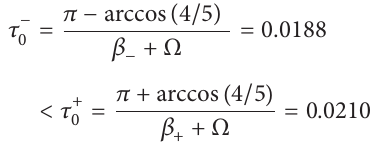
and V 2 (𝜃) satisfies [( 𝑖𝛽 V (𝜃) ± 2